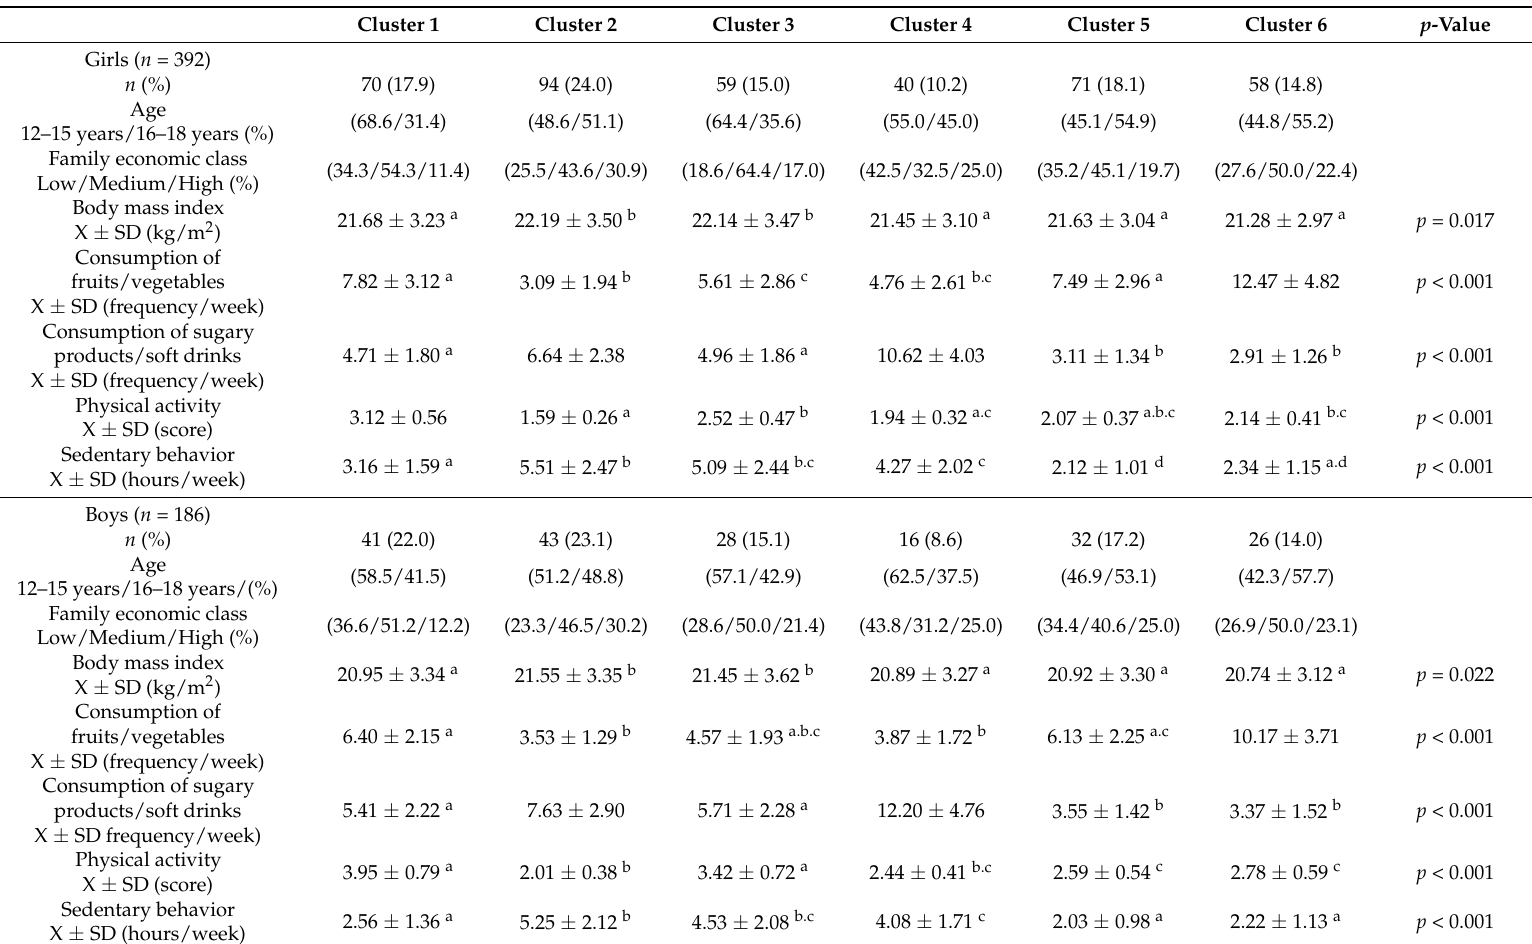
Table 2. Demographic indicators, dietary habits, physical activity and sedentary behavior according to cluster